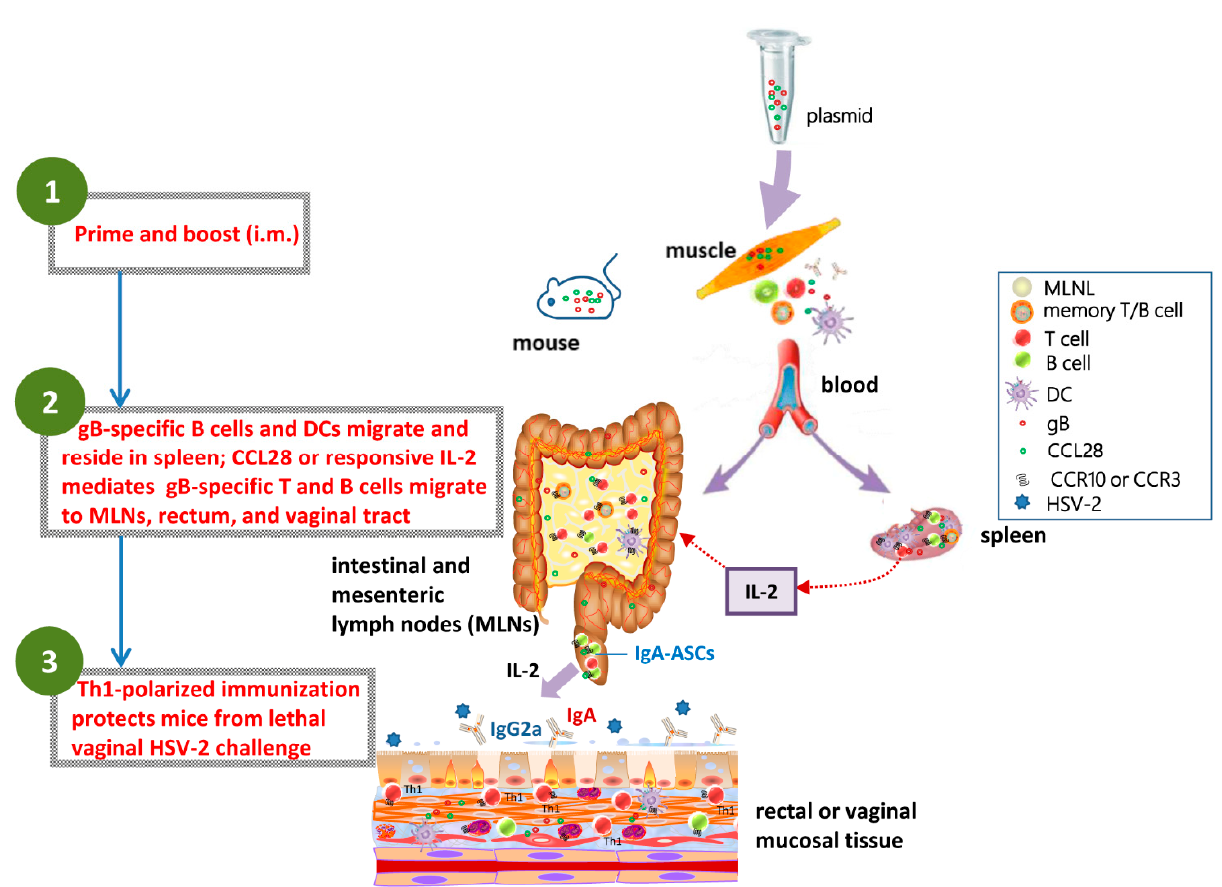
Figure 7. Diagram of how CCL28 mediates gB-specific, Th1-polarized immune responses to protect against vaginal challenge in mice. DNA vaccines containing pgB + pCCL28 can distribute and express throughout the body via blood flow after i.m. injection. When peripheral blood immunocytes circulate, they follow the bloodstream to the spleen, MLNs, and rectal sites, whereas CCR10 + B cells and CCR10 + DCs tend to reside in the spleen, CCR10 + T cells tend to reside in MLNs, and CCL28-responsive IgA-ASCs tend to reside in rectal sites. The diagram shows how CCL28 enhances IL-2-initiated, Th1-polarized immunity and promotes the immune responses to effectively protect mice against HSV-2